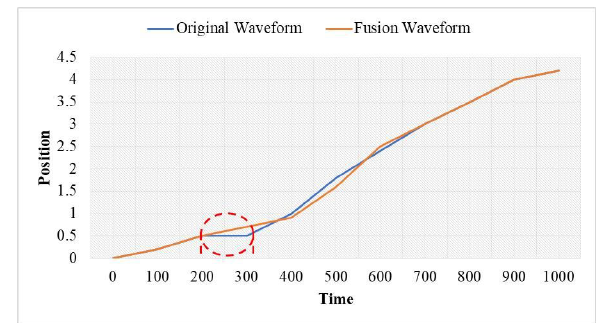
Figure 12: Simulated outcomes for position